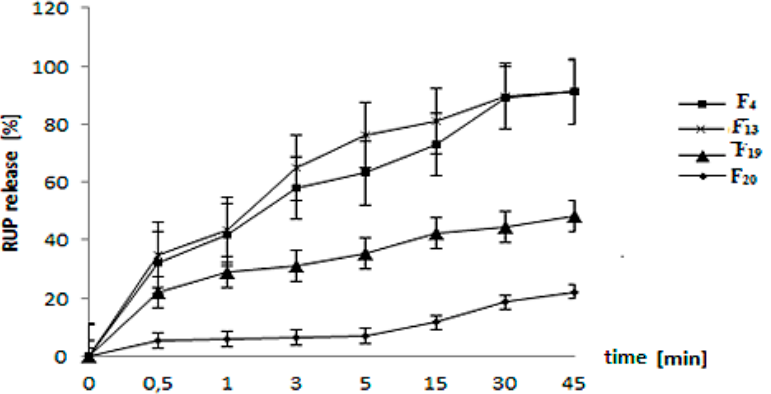
Figure 3. Rupatadine fumarate (RUP) release from formulations F 4 , F 13 , F 19 , and F 20 in phosphate buffer pH = 6.8.